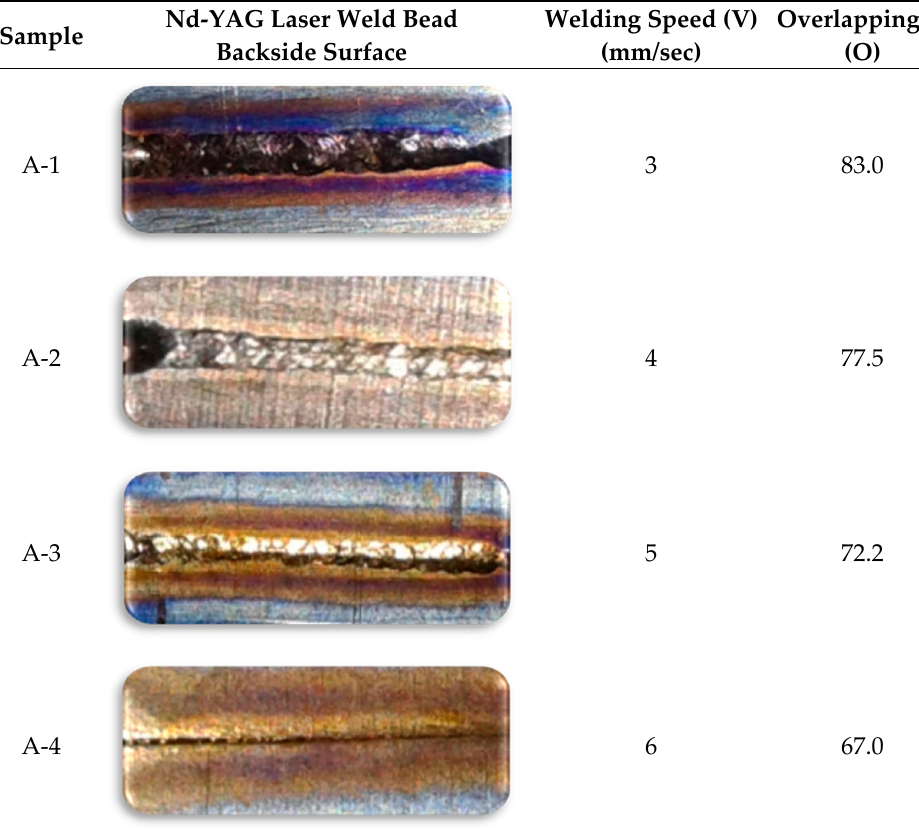
Figure 3. Face side images of the weld bead with di ff erent overlapping percentages and welding speeds with a magni fi cation scale of 50×.